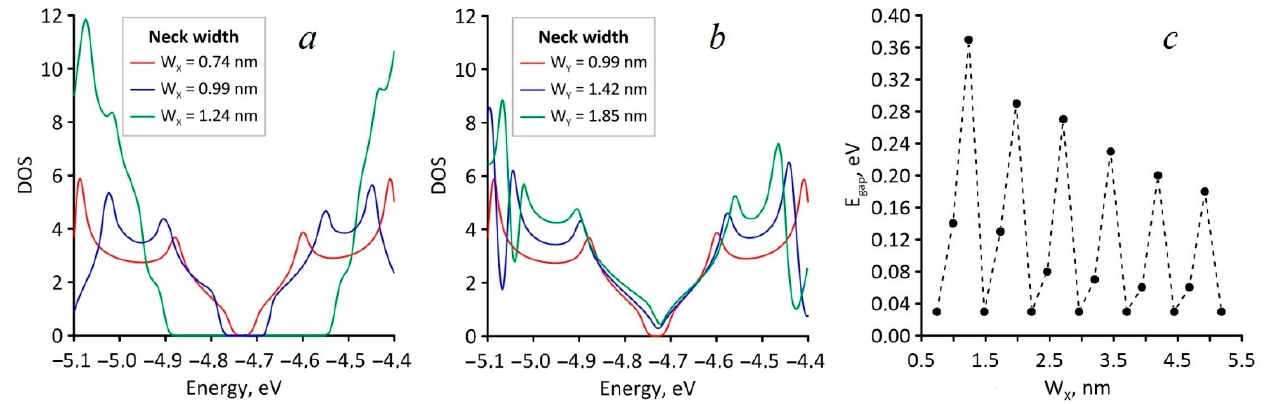
Figure 2. Electronic properties of HG: ( a ) DOS with increasing of W X (zigzag direction); ( b ) DOS with increasing of W Y (armchair direction); ( c ) dependence of energy gap on W X .